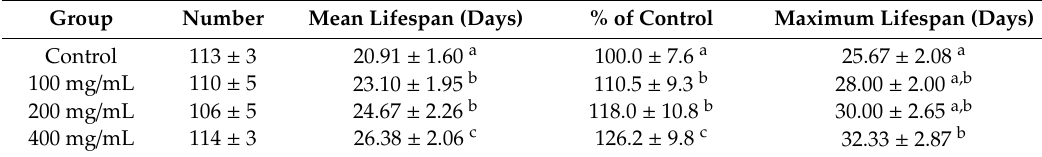
Figure 2. Effect of orange extracts on the lifespan of N2 wild-type C. elegans . Day 1 adult nematodes at the L4 stage (fourth larval stages) were treated with and without orange extracts (0, 100, 200, or 400 mg/mL) at 20 °C. The survival was counted starting from day 1 of adulthood to death.